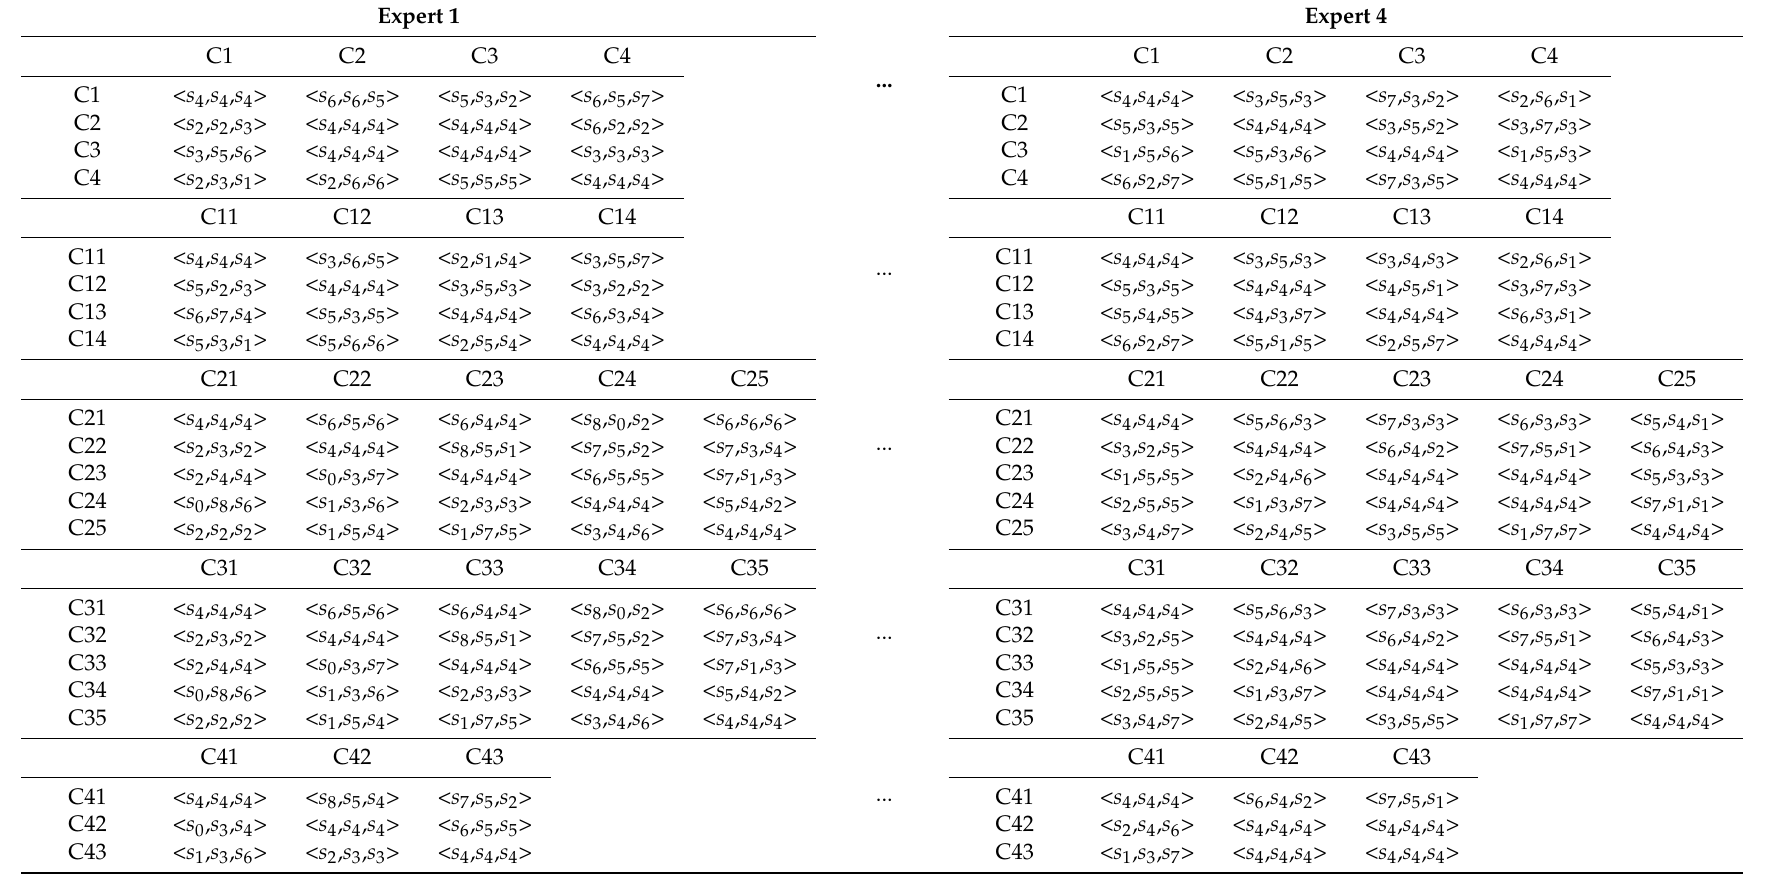
Table 2. Expert comparison in the pairs of criteria/subcriteria. Expert 1